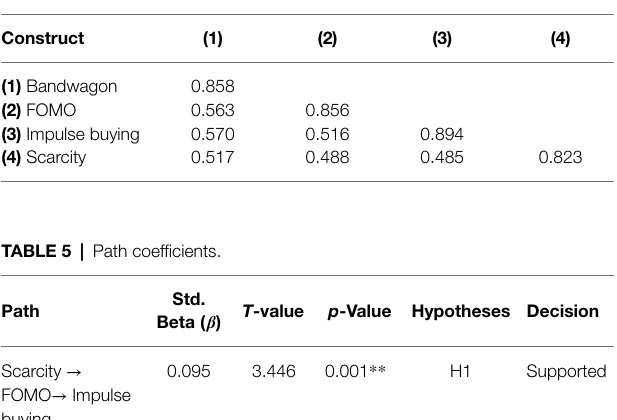
TABLE 4 | Discriminant validity assessment using Fornell–Larcker